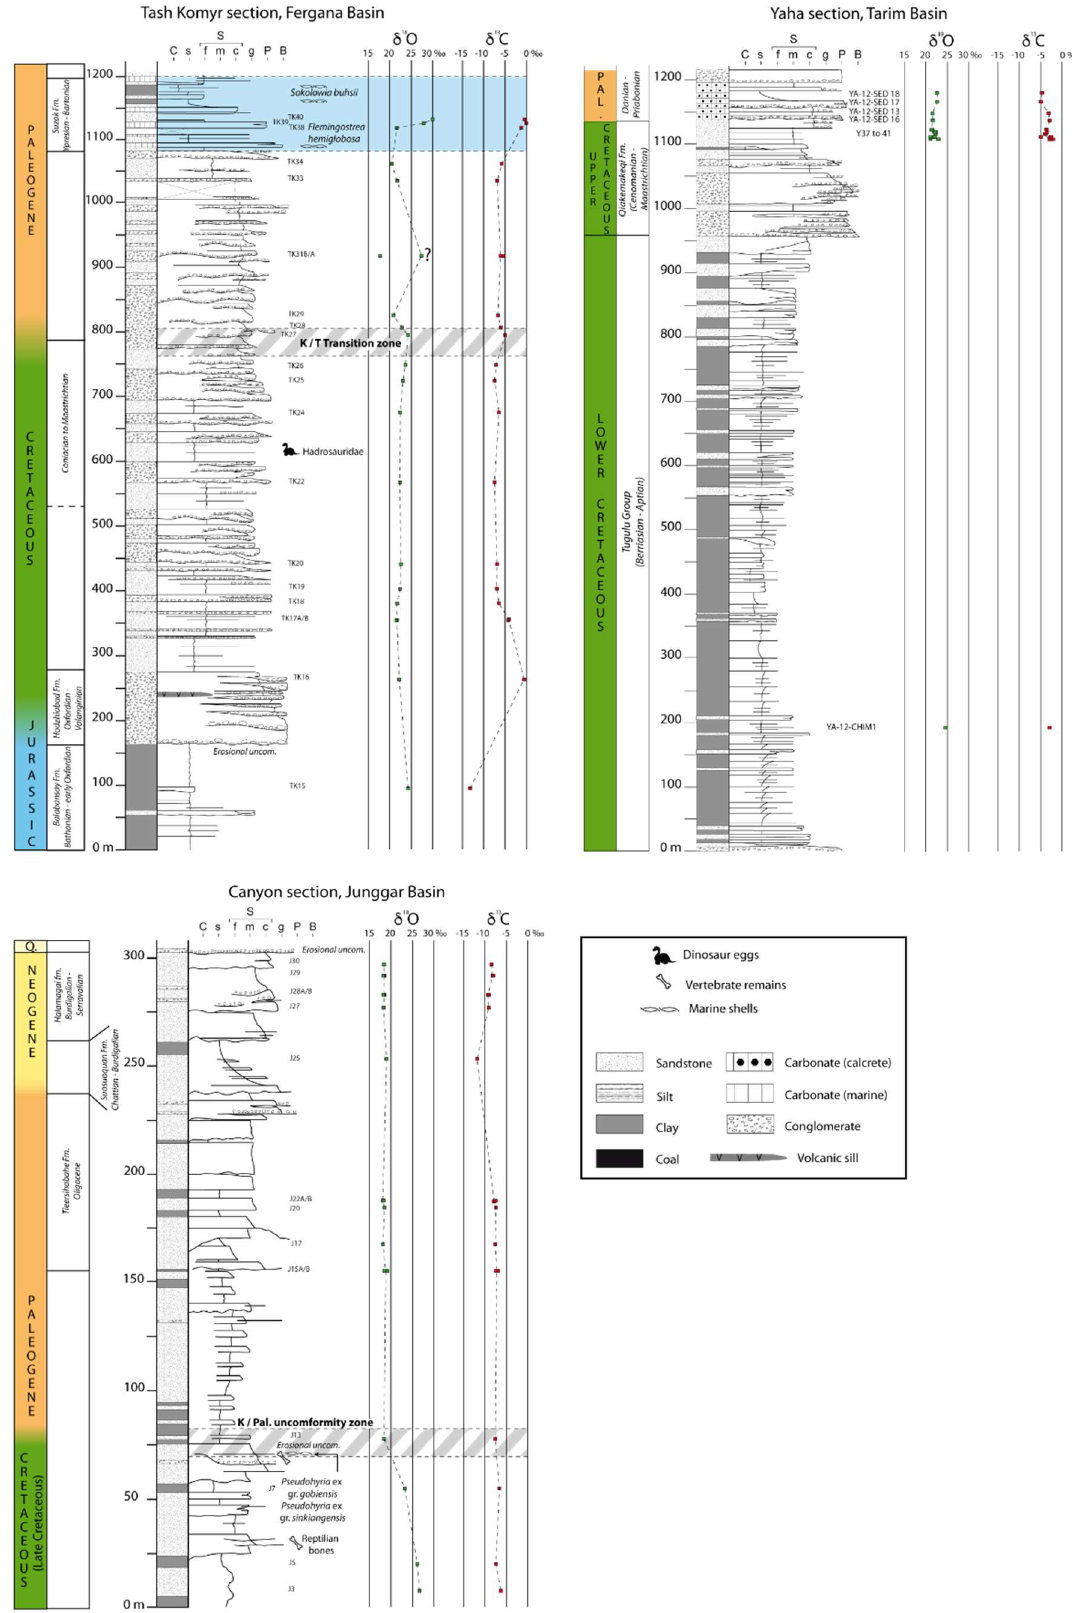
Figure 2. Stratigraphic sections from the three main locations studied in this work, with δ 18 O (in reference to VSMOW) and δ 13 C (in reference to VPDB) values. In the Tash Komyr section, the blue shading corresponds to series including marine sediments of the proto-Paratethys sea (modified from [63]). See Table 1 for details on isotopic compositions.